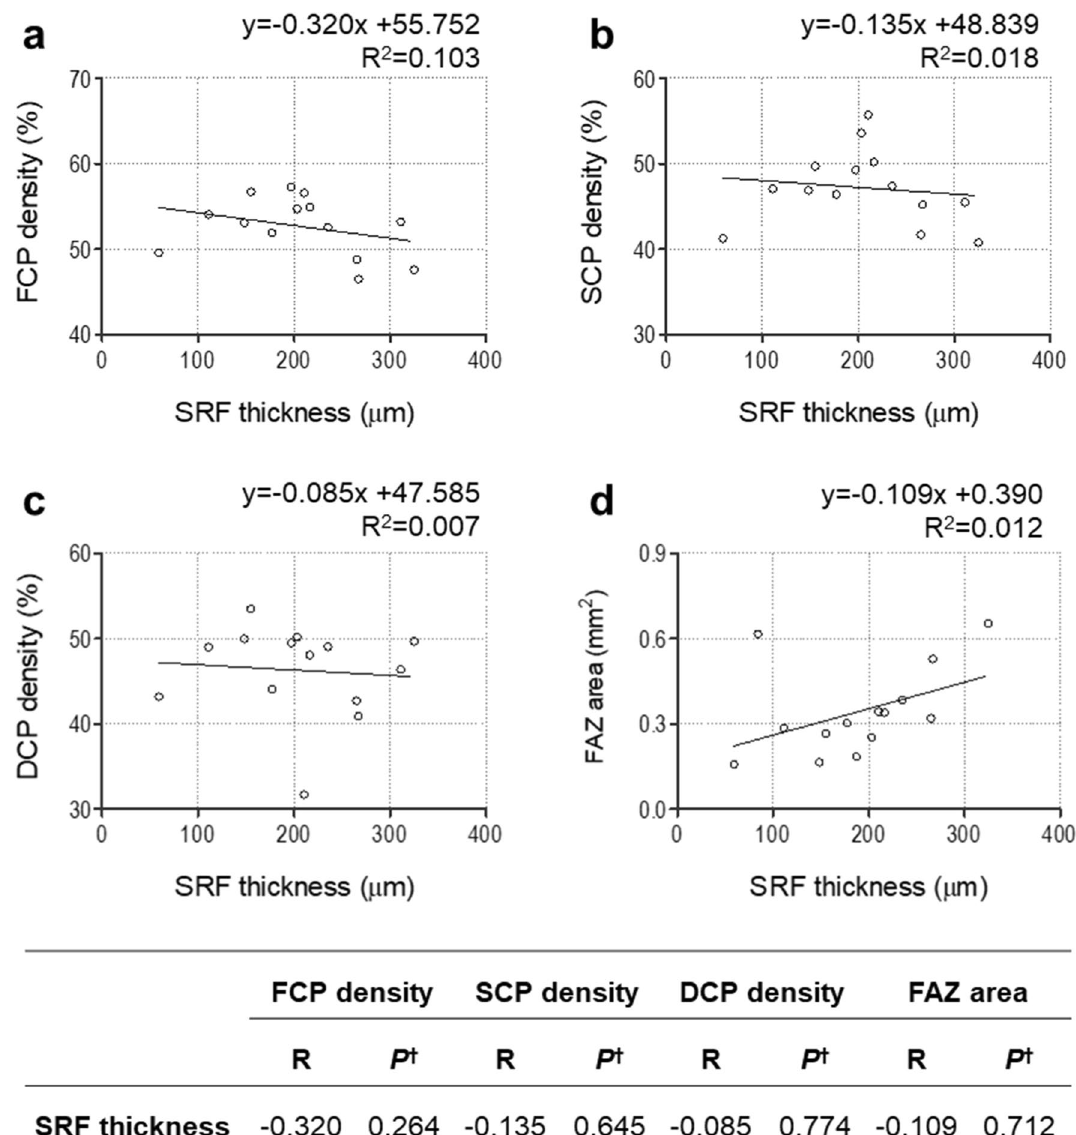
Figure 2. Relationship between subretinal fluid (SRF) thickness and OCTA parameters: FCP density (a) , SCP density (b) , DCP density (c) , and FAZ area (d) in central serous chorioretinopathy. † Pearson’s correlation. SRF subretinal fluid, DCP deep capillary plexus, FAZ foveal avascular zone, FCP full capillary plexus, SCP superficial capillary flexus, SRF subretinal